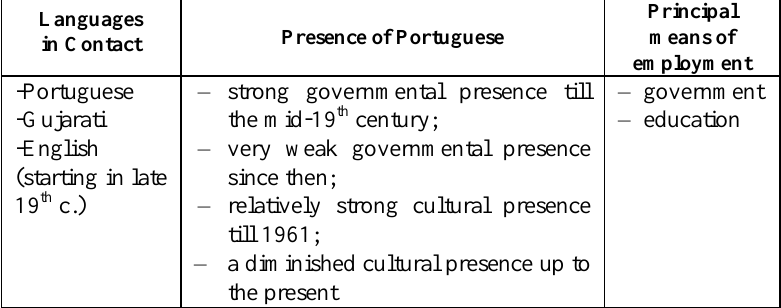
Table III. Information on the Diu Christian community